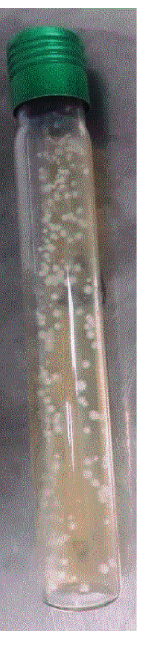
Figure 1: Macroscopic examination of the appearance of Candida on Sabouraud Chloramphenicol culture medium.